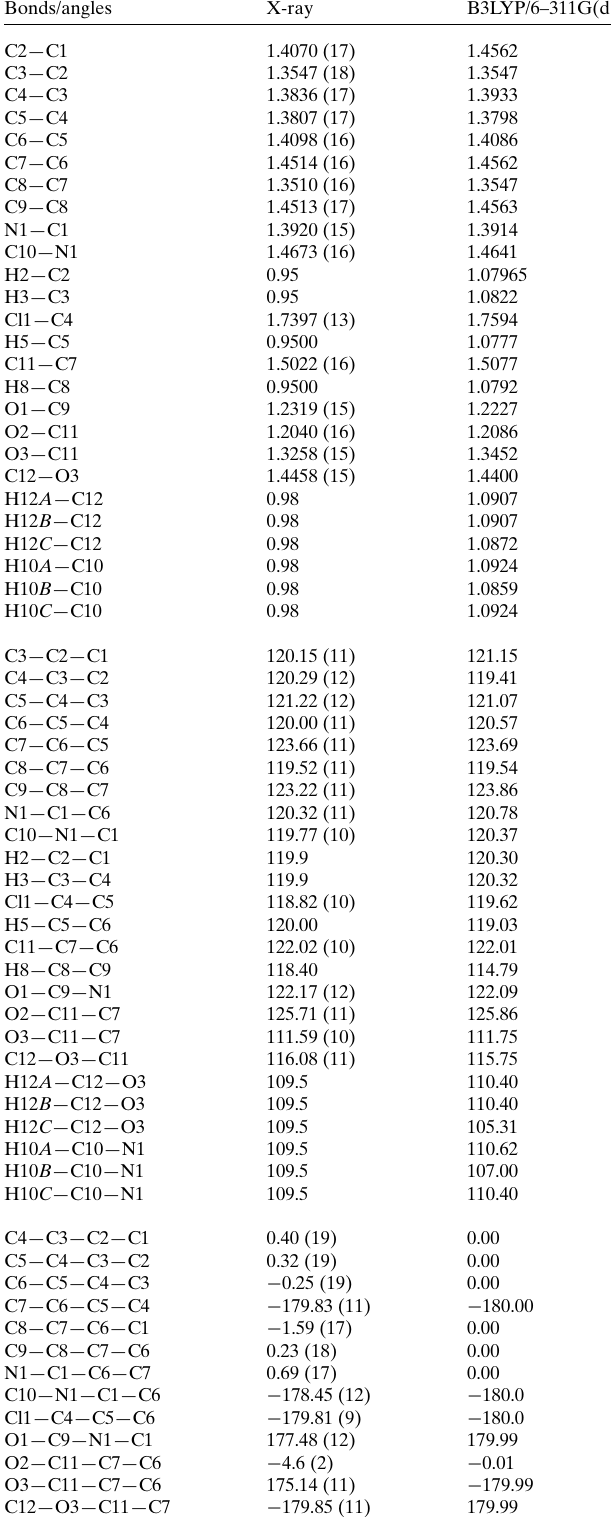
Table 3 B3LY/6–311G(d,p) equilibrium structural parameters (A˚ , (cid:2) ) and X-ray analysis of the title compound,